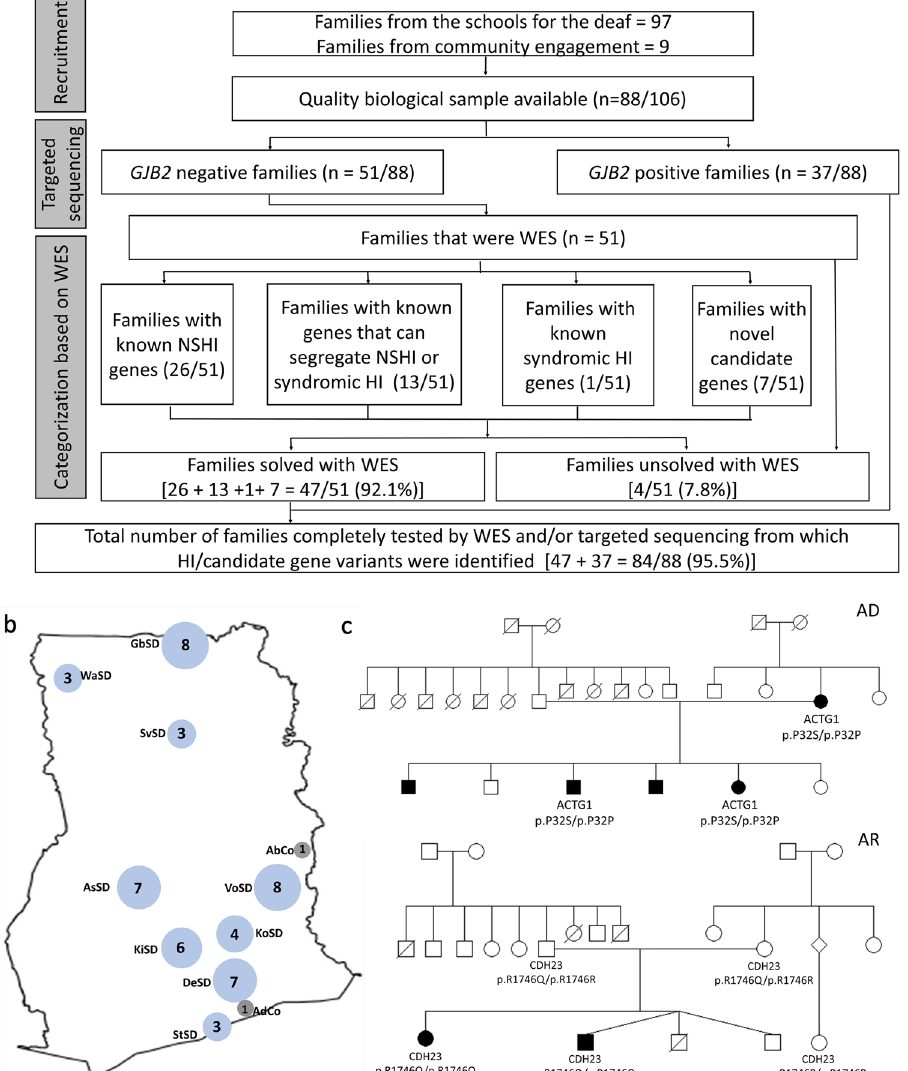
Fig. 1 Summary of patient enrollment in Ghana. a Flow diagram of the study. b National recruitment sites for families with HI ( n = 51) considered for WES. Blue circles denote schools for the deaf and the number of recruited families written in the circles. State School for the Deaf (StSD) in Greater Accra Region, Gbeogo School for the Deaf (GbSD) in Upper East Region, Volta School for the Deaf (VoSD) in Volta Region, Ashanti School for the Deaf (AsSD) in Ashanti Region, Koforidua School for the Deaf (KoSD), Kyebi School for the Deaf (KiSD), and Demonstration School for the Deaf (DeSD) in Eastern Region, Savelugu School for the Deaf (SvSD) in Northern Region, and Wa School for the Deaf (WaSD) in Upper West Region. Gray circles represent communities, Abotoase (AbCo), and Adamorobe (AdCo). c Representative families with autosomal dominant (AD) and autosomal recessive (AR) mode of